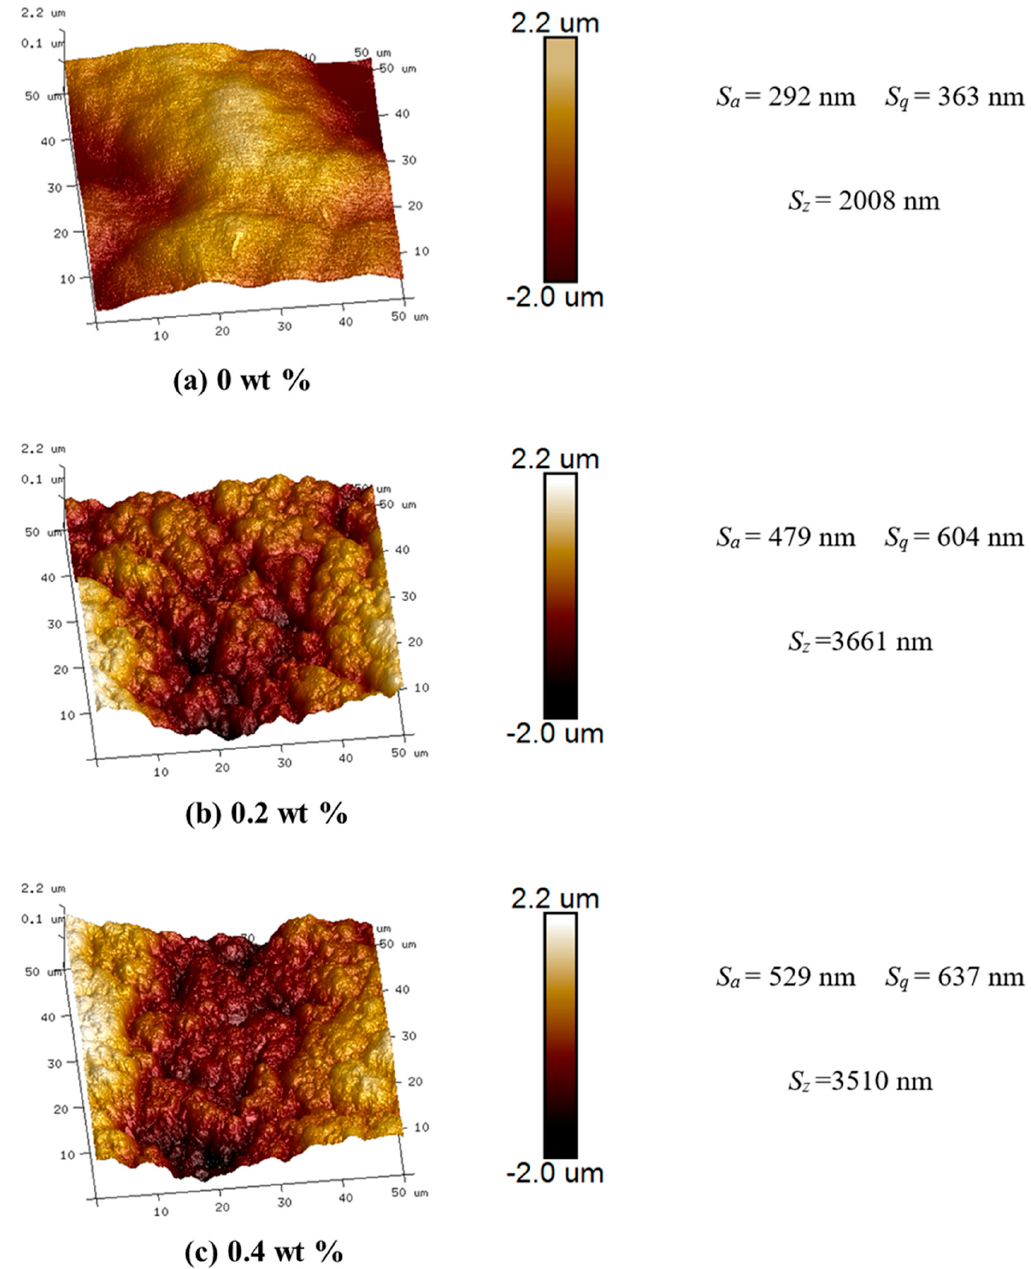
Figure 5. Three-dimensional topographies and surface roughness of the low gloss acrylic polymer films with crosslinker AMA contents ranging from ( a ) 0 wt % to ( b ) 0.2 wt % and to ( c ) 0.4 wt %, respectively.